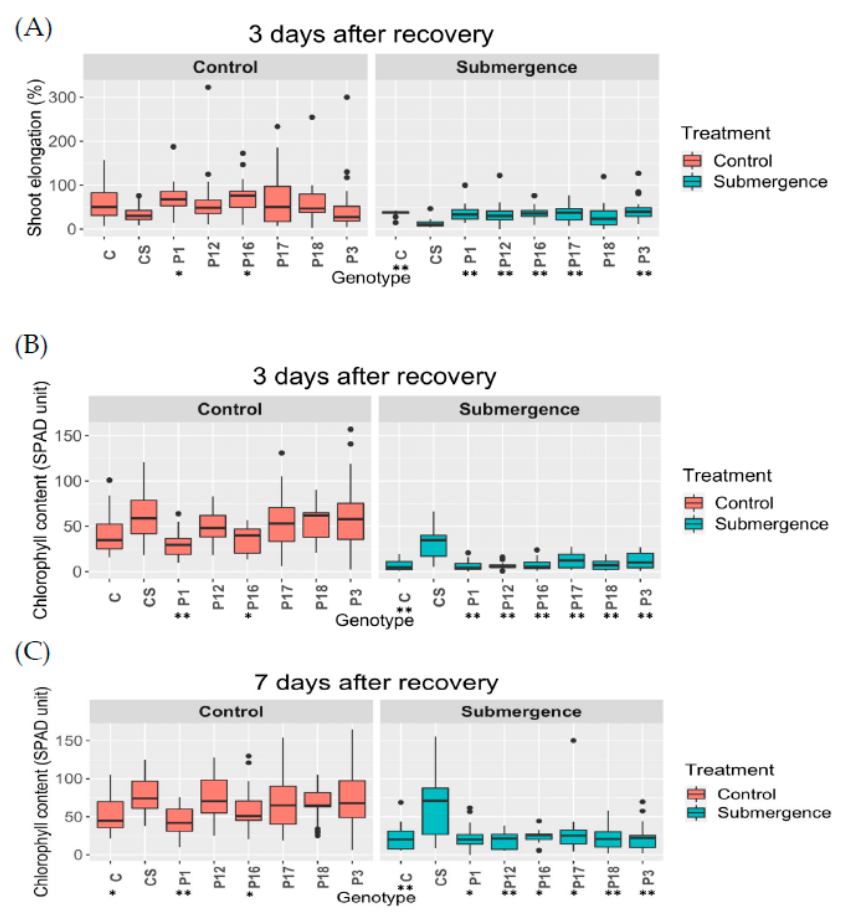
Figure 4. Shoot elongation rate and chlorophyll content of control and submerged plants. ( A ) Shoot elongation rate at three days after desubmergence. Chlorophyll content at three days ( B ) and seven days ( C ) after desubmergence. “C” indicates Ciherang; “CS” indicates Ciherang-Sub1; “P1” indicates plant #1; “P3” indicates plant #3; “P12” indicates plant #12; “P16” indicates plant #16; “P17” indicates plant #17; and “P18” indicates plant #18. “*” indicates p -value < 0.05 compared with Ciherang-Sub1; “**” indicates p -value < 0.01 compared with